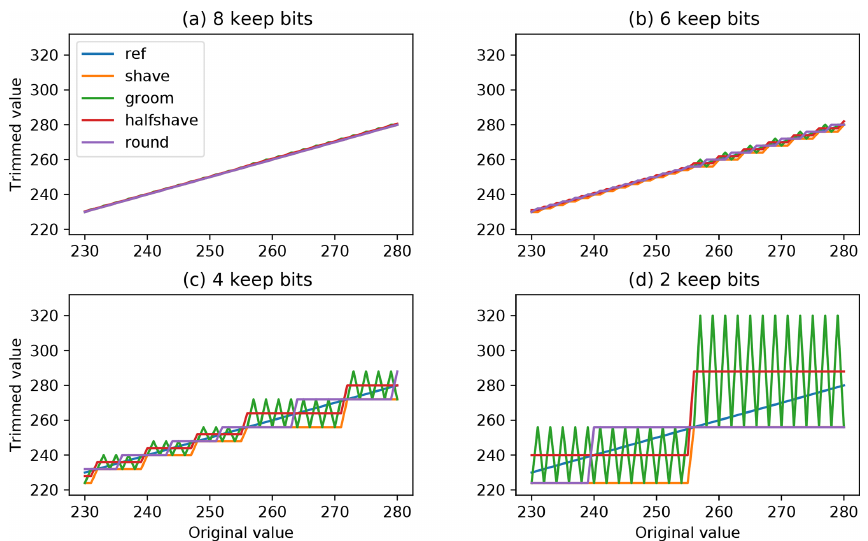
Figure 1. Trimmed values as a function of original values when trimmed to different numbers of keep bits. The lines correspond to the different trimming methods. Table 1. The discretization level increment for different numbers of the mantissa bits kept and the maximum relative error introduced by trimming the precision with various methods. Mantissa size (bit) Keep bits Discretization level increment Max relative error as a fraction of the value Shave, Set, Groom Round,